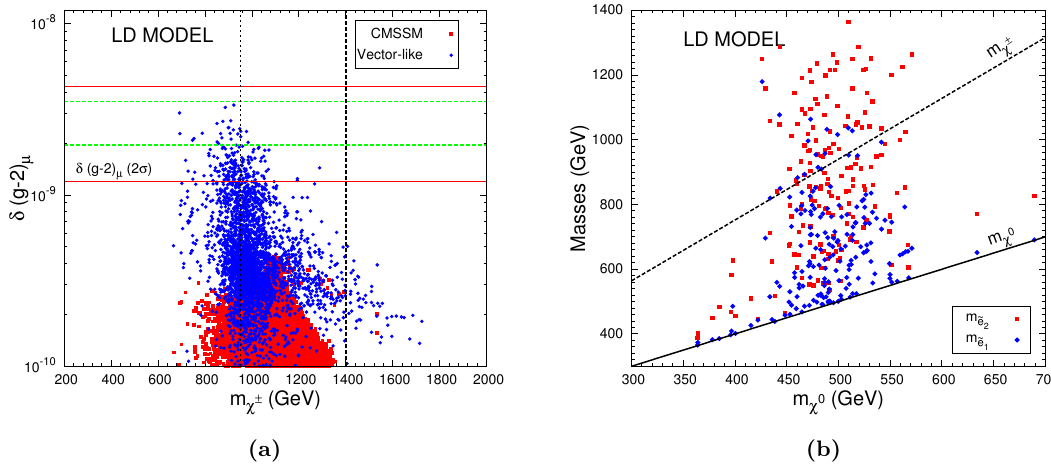
Figure 11. (a) Comparison of the calculation of (cid:14) ( g versus the CMSSM (red squares). The horizontal red solid lines indicate the current (cid:14) ( g region, while the horizontal green dashed ones show the projected 2 (cid:27) region of the upcoming New Muon g-2 experiment, assuming the measured (cid:14) ( g lines show the current (thin) and projected (thick) bounds from 3-lepton searches [87, 88] in